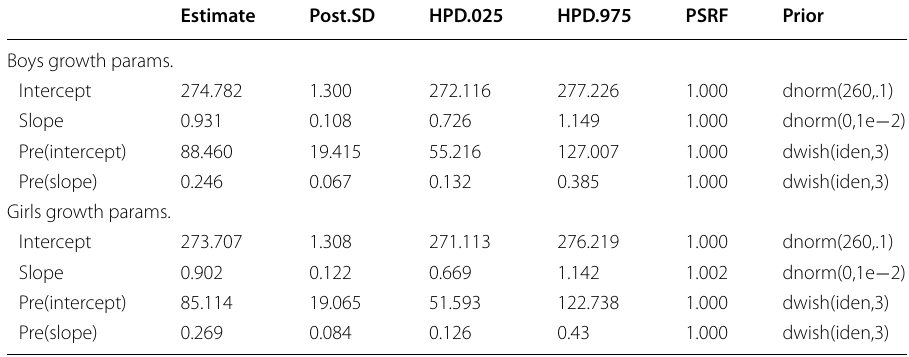
1/variance. dnorm is the normal N (µ , τ 2 ) distribution, where =